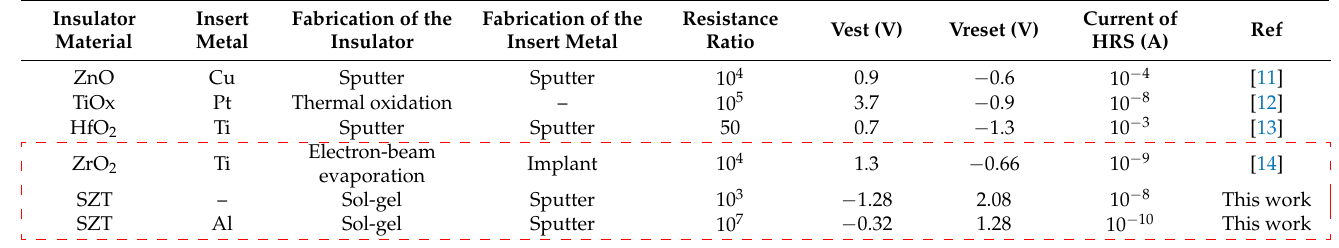
Table 1. Performance comparison of the SZT-based RRAM devices with reported data.